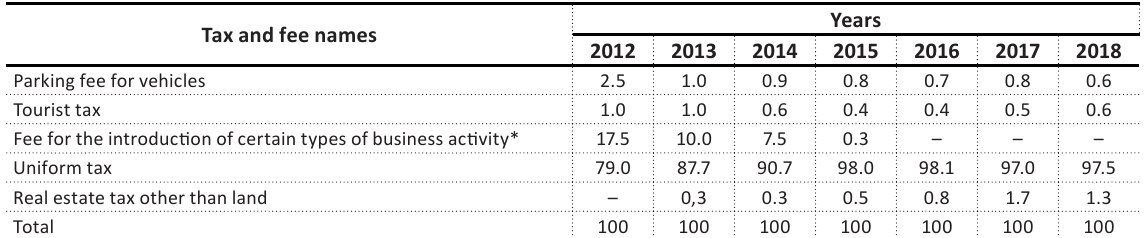
Table 1. Structure of local taxes and fees,